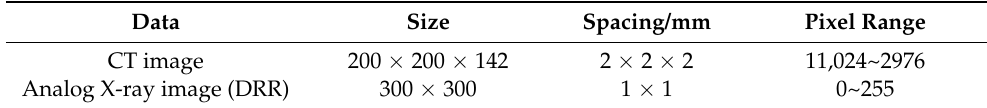
Table 1. Related parameters of image registration.